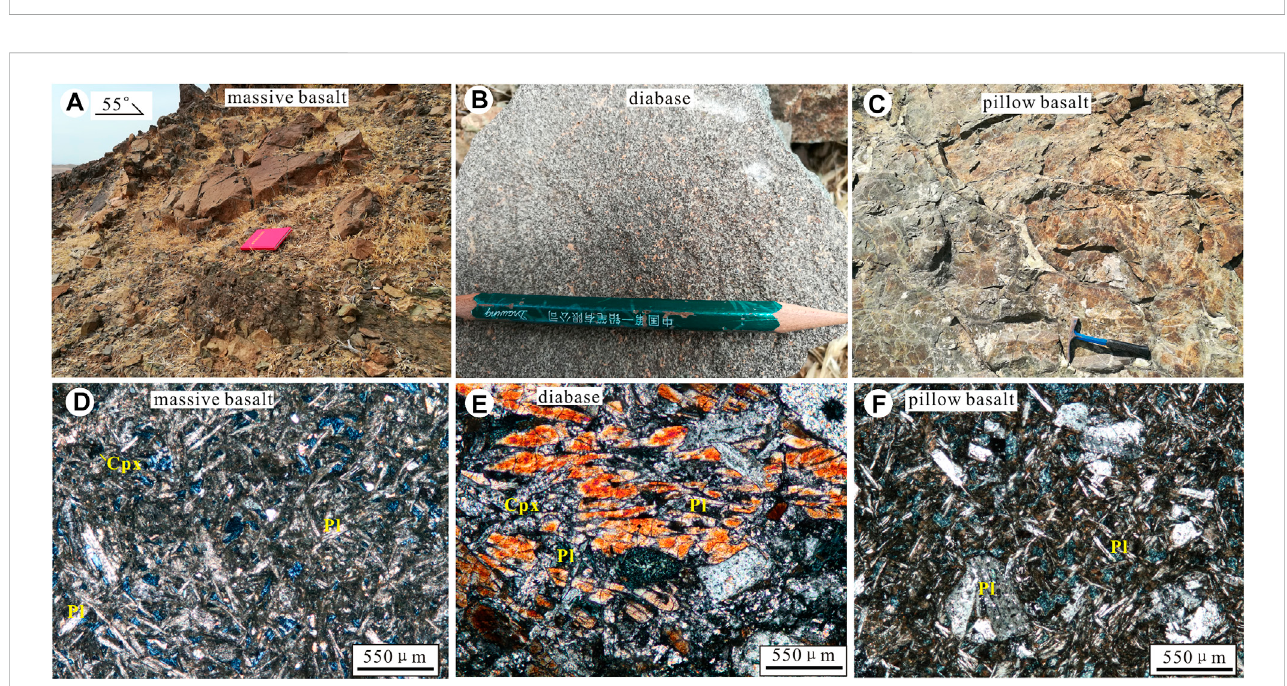
FIGURE 3 Representative photographs and photomicrographs (cross-polarized light) of the basic igneous rocks in the Bairin Right Banner area. (A) massive basalt outcrop; (B) diabase outcrop; (C) pillow basalt outcrop; (D) massivephotomicrograph; (E) diabasephotomicrograph; (F) pillow basalt photomicrograph; Cpx: Clinopyroxene; Pl: